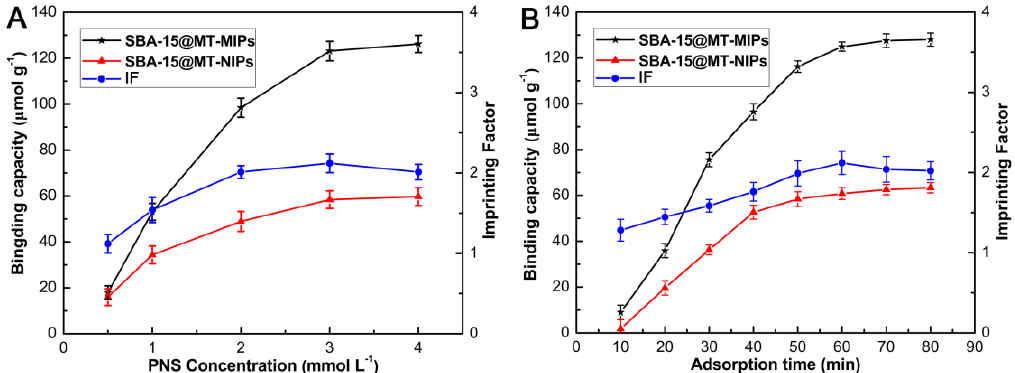
Figure 6. ( A ) Adsorption isotherms and imprinting factors for SBA-15@MT-MIPs and SBA-15@MT- NIPs with different concentrations of the mixture solution of Rb 1 , Rg 1 and R 1 , where IF was defined as IF = Q MIP / Q NIP ; ( B ) Adsorption kinetic behaviors of SBA-15@MT-MIPs and SBA-15@MT-NIPs for Rg 1 , Rb 1 , R 1 with corresponding imprinting factors.